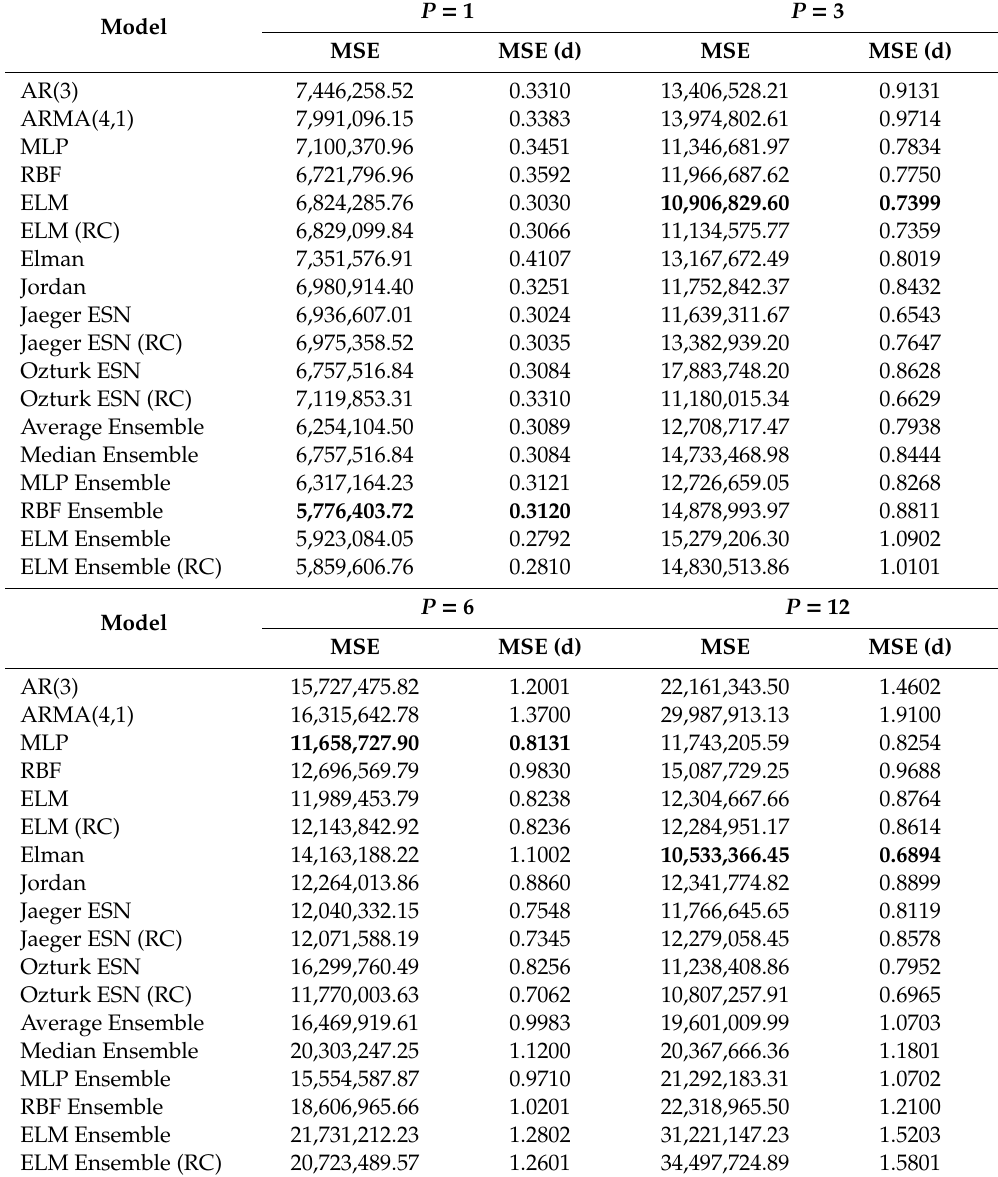
Table 6. Computational results for Tucuru í